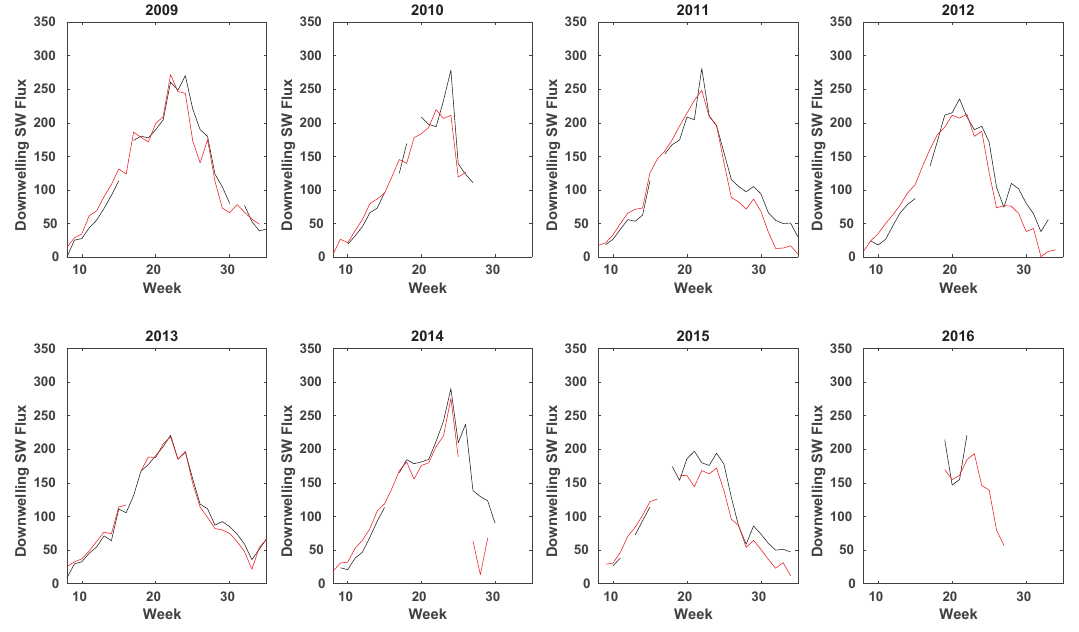
Figure 8. Mean downwelling shortwave radiation in W/m 2 for surviving ( black ) and melted ( red ) parcels during